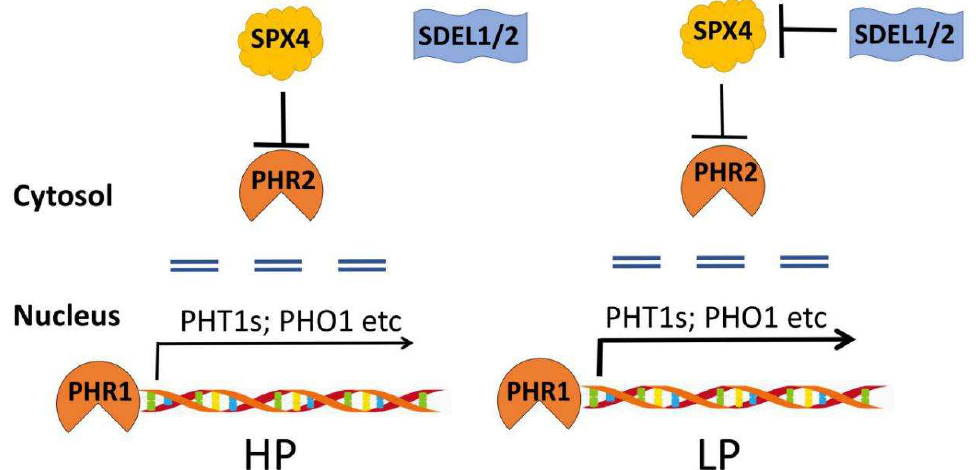
Figure 4. Ubiquitination-mediated translational regulation of the phosphate starvation response [60,61]. In high phosphate conditions, OsSPX4 interacts with OsPHR2, and reduces its ability to bind P1BS motifs and activate the expression of downstream regulators. In low phosphate conditions, OsSDEL1 / 2 competes with OsPHR2 to interact with OsSPX4, resulting in the degradation of OsSPX4 and the liberation of OsPHR2. OsPHR2 is translocated into the nucleus, which activates the expression of the downstream genes. Double horizontal dotted lines mean the nuclear membrane. The thickness of black arrows indicate the transcriptional activation level.